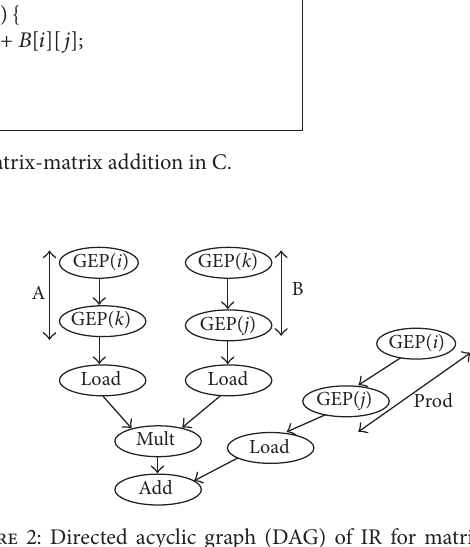
Figure 2: Directed acyclic graph (DAG) of IR for matrix-matrix multiplication.